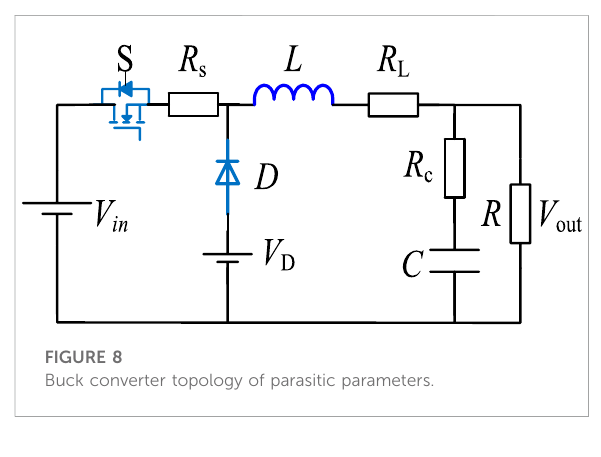
FIGURE 7 Relationship of I p , P out , and Vi n in the DCM